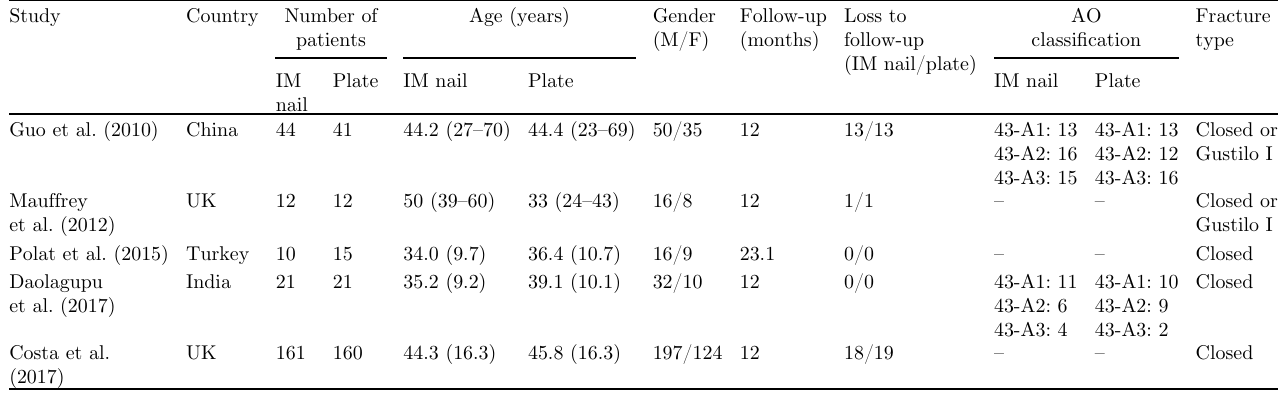
Table 1. Study characteristics.